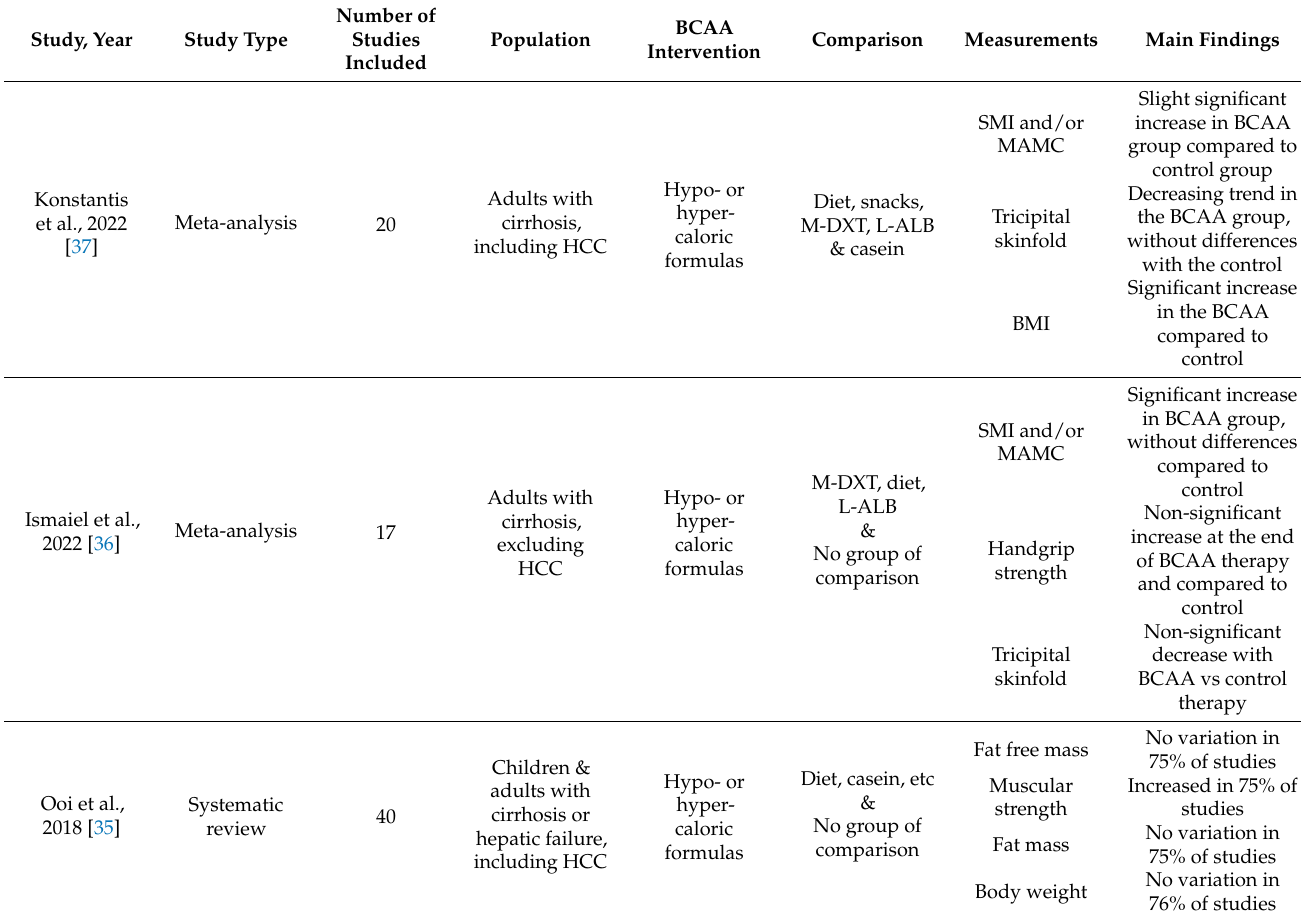
Table 3. Characteristics of the main review articles on BCAA supplementation in